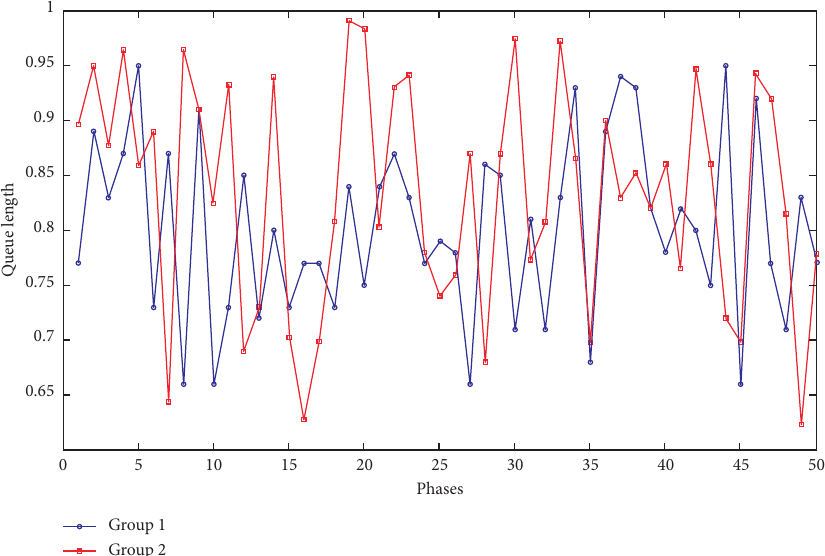
Figure 9: Variations in queue length at intersection 8 under high congestion